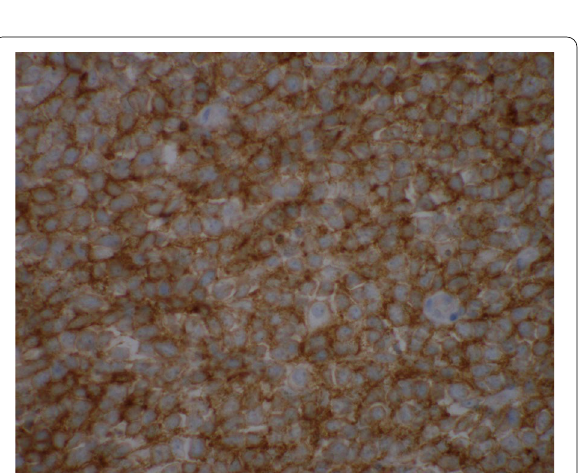
20 magnification) ×